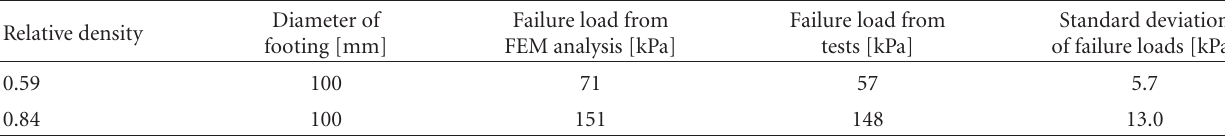
Table 5: Summary of results from tests and FEM calculations.